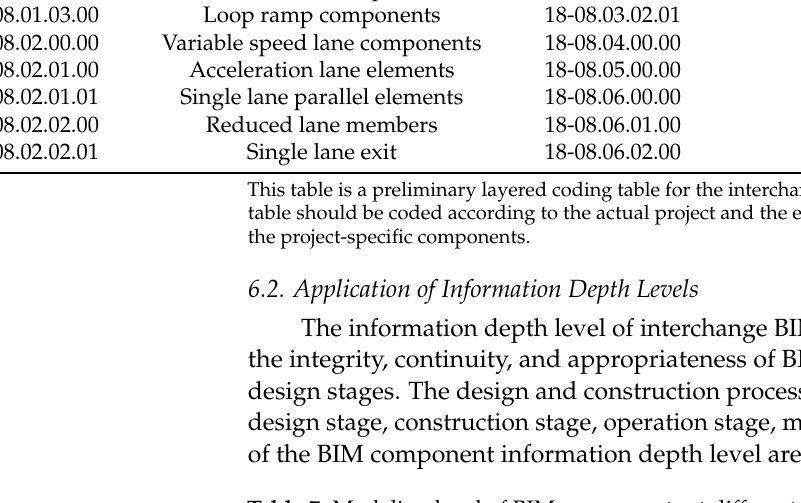
Table 7. Modeling level of BIM components at different